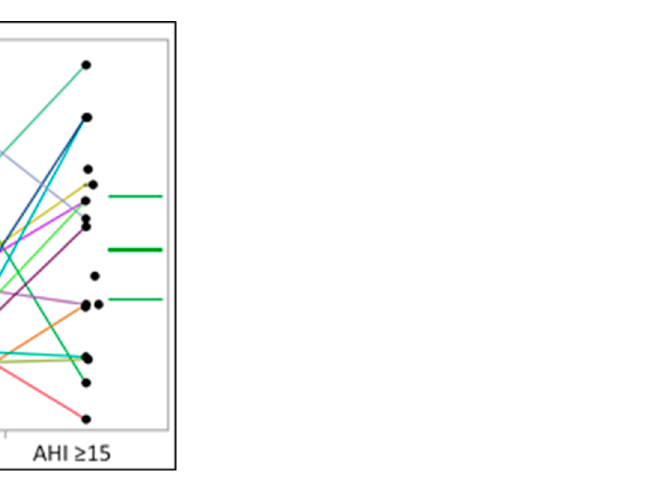
CRP-C—reactive protein. HbA1c—glycated hemoglobin. The non-normal distributed values are presented as median and interquartile range (IQR).